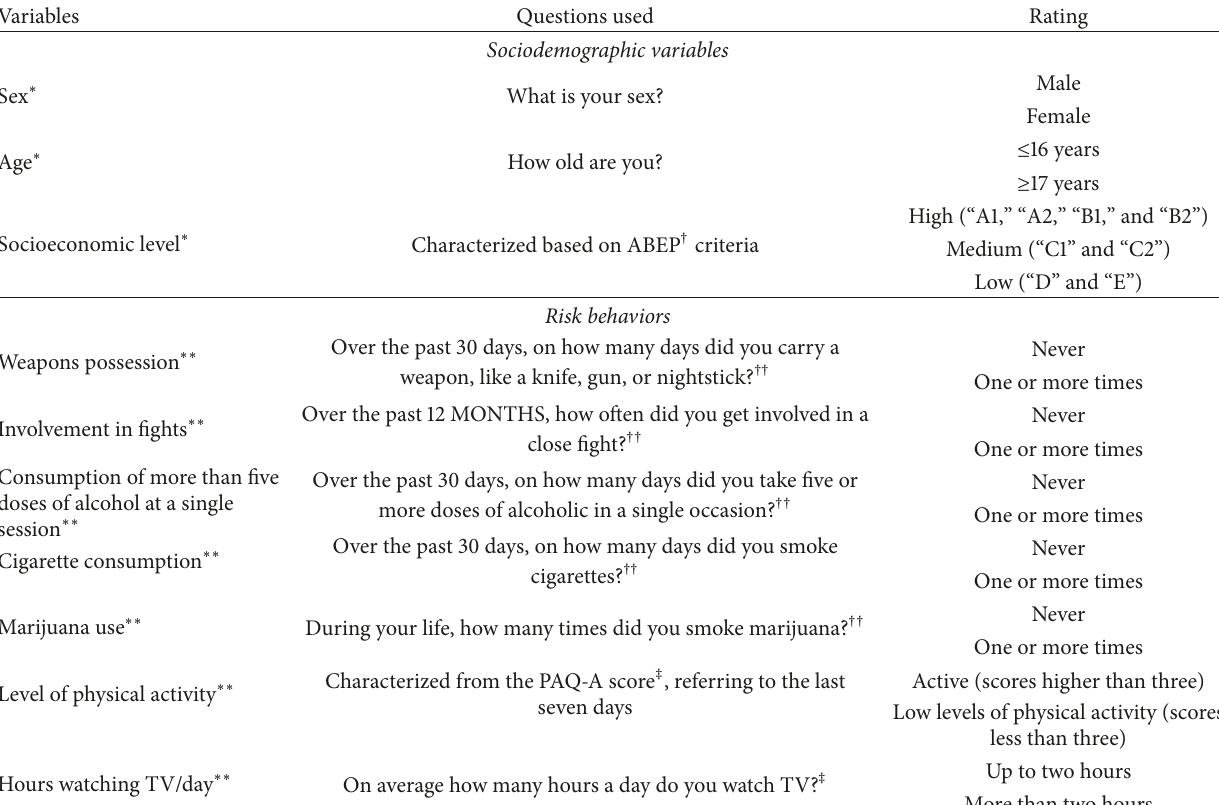
Table 1: Definition of the variables used in the study.